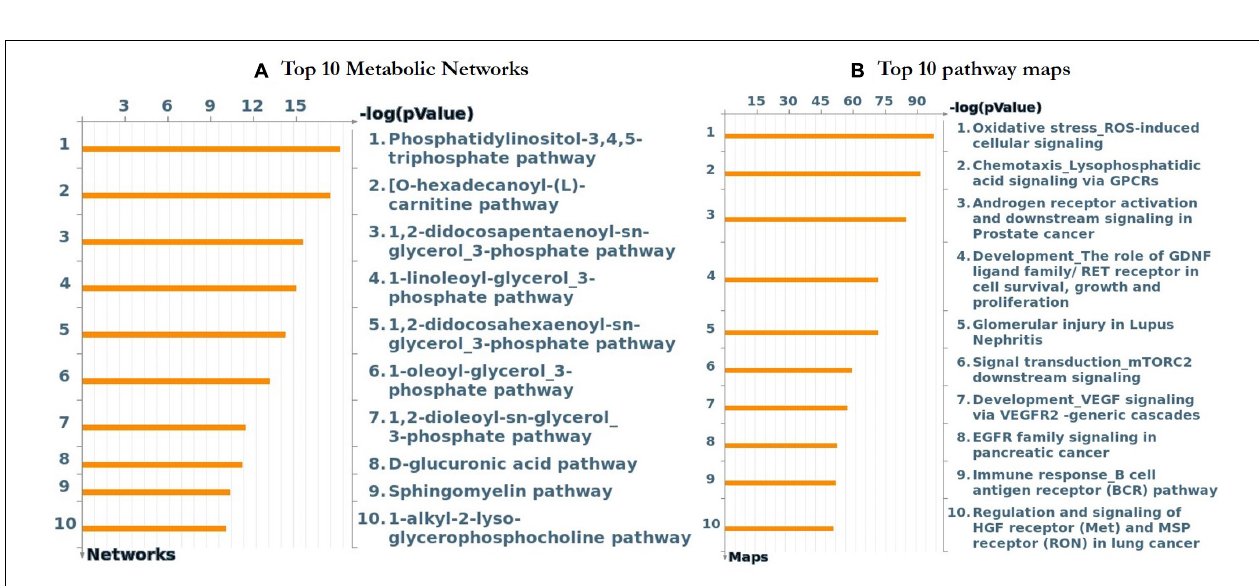
FIGURE 5 | The top 10 metabolic networks and pathway maps were annotated using GeneGo enrichment analysis for the genes that are differentially expressed from SLE patients vs. healthy controls, respectively. (A) The content of these metabolic networks was annotated and defined by GeneGo Cortellis Solution software. Each process represents a pre-set network of protein interactions characteristic for the process, and sorting was performed for the metabolic networks that are statistically significant. (B) The pathway maps (canonical) of GeneGo display a series of signals and metabolic charts that cover human in a structured manner. The significant expression of a gene/protein represented in histogram